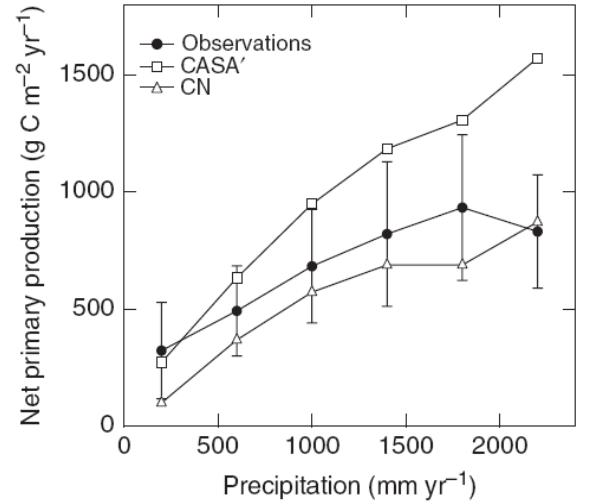
Fig. 4. Functional relationship between net primary production with precipitation used in a benchmark analysis for coupled models that account for possible biases in model climate (adopted from Rander- son et al., 2009).